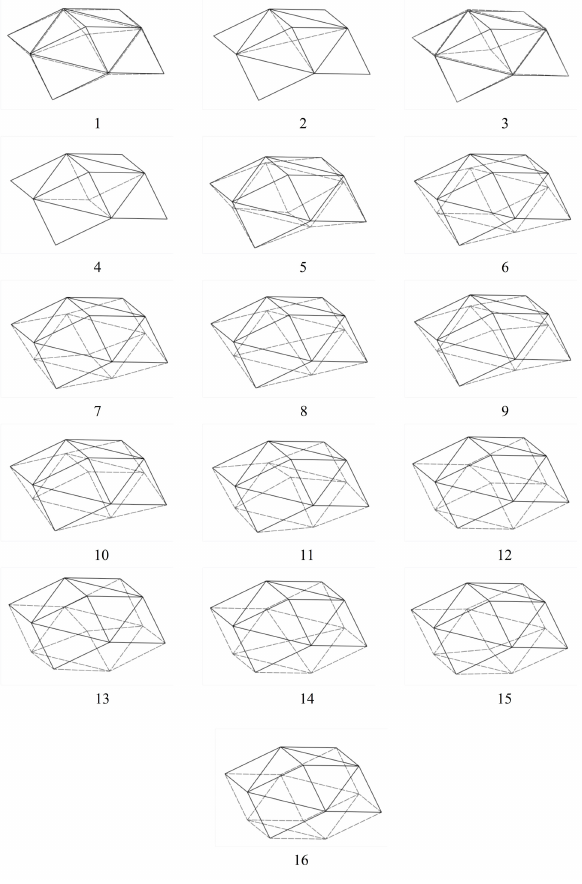
Figure 12: Sixteen-member structure displacements (Case 1 - λ up